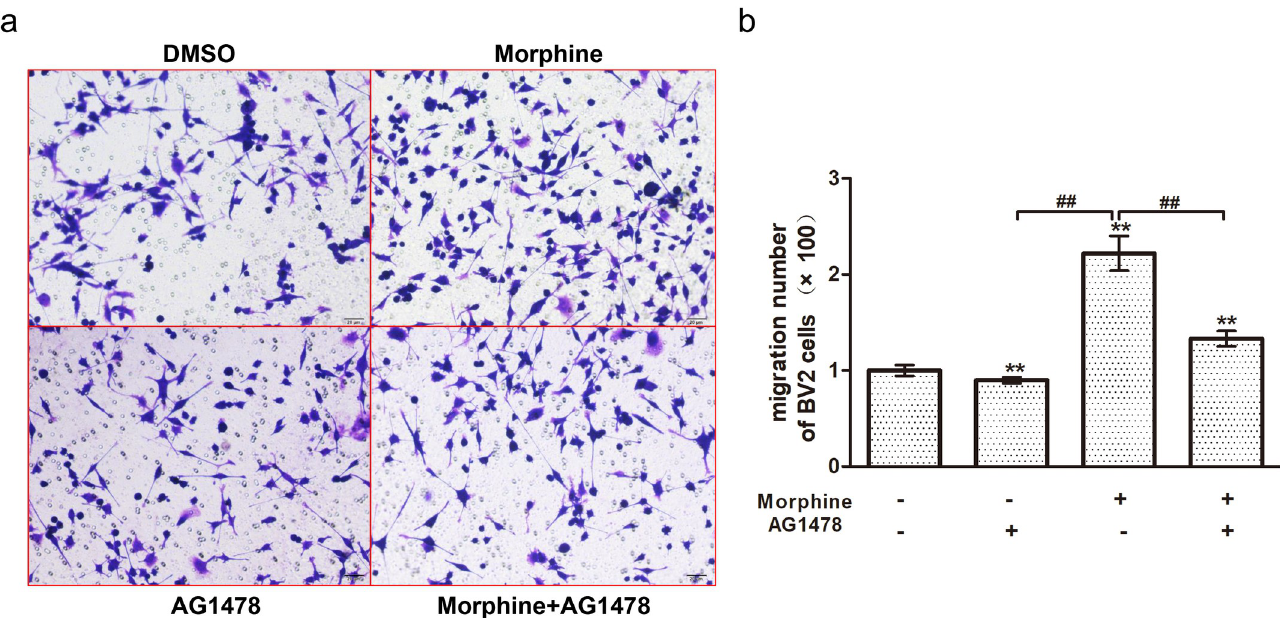
Fig 6. The effect of EGFR inhibition on migration of BV-2 cells induced by morphine. (a) BV-2 cells were treated with morphine or AG1478 for 48 h, and the number of migrated cells was evaluated by the Transwell assay. Scale bar: 20 μ m. (b) Migration of BV-2 cells in six randomly selected fields from each group was quantified. Data are expressed as the means ± SEMs. All data were analyzed using ANOVA. � p < 0.05 and �� p < 0.01 compared to DMSO groups. ## p < 0.01 morphine vs. morphine +